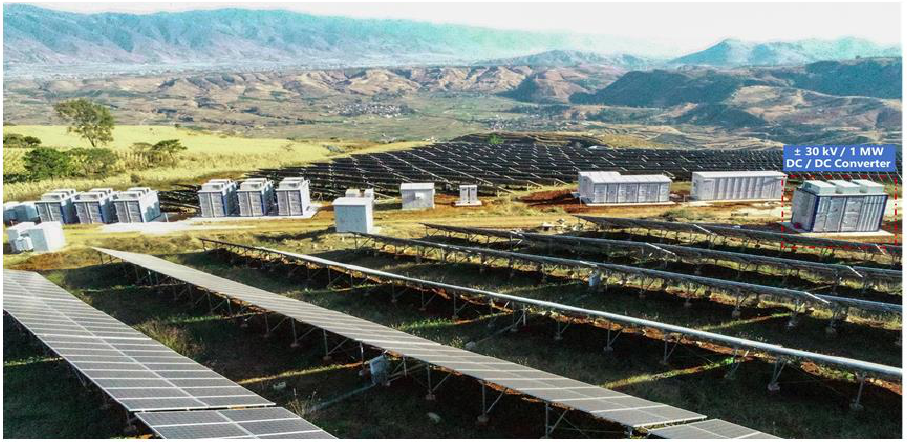
Figure 27. ±30 kV/1 MW PV HVDC collection and grid-connection demonstration system.